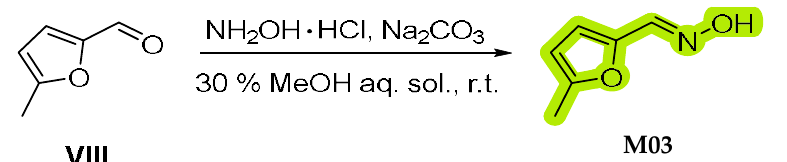
Figure 14. Traditional method for the preparation of compound M03 . Starting material VIII is com- mercially available.